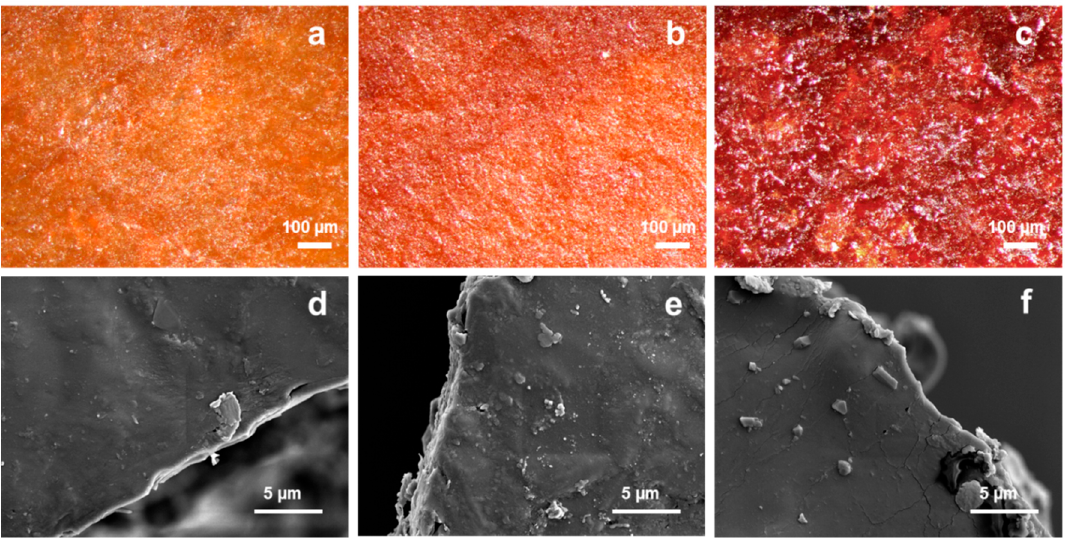
Figure 8. Optical microscopic images of ( a ) F50-T50-F, ( b ) F40-T60-F and ( c ) F30-T70-F; SEM images of ( d ) F50-T50-F, ( e ) F40-T60-F and ( f ) F30-T70-F at 10,000× magnification.